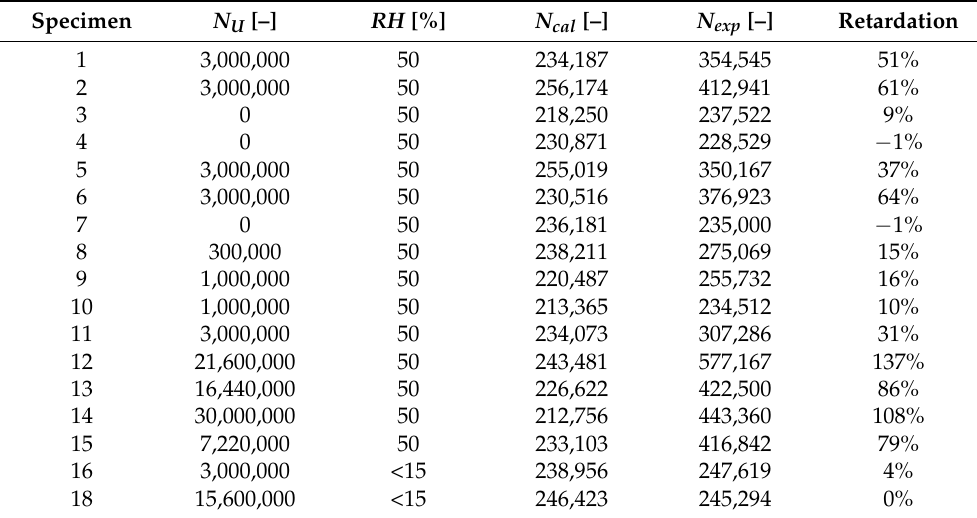
Table 4. Numbers of base load cycles needed for crack increment of 0.5 mm with ( N exp ) and without ( N cal ) the effect of underload